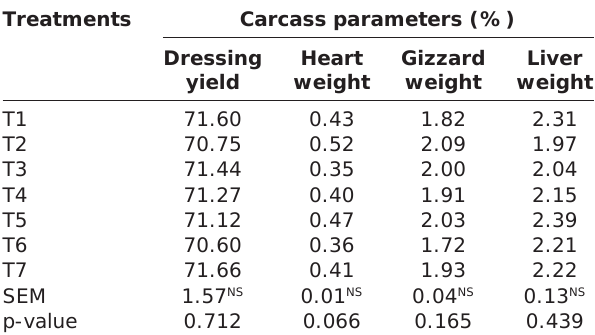
Table-3: Effect of supplementing garlic and NLPs and their combinations on carcass yields of broiler at 42 day of